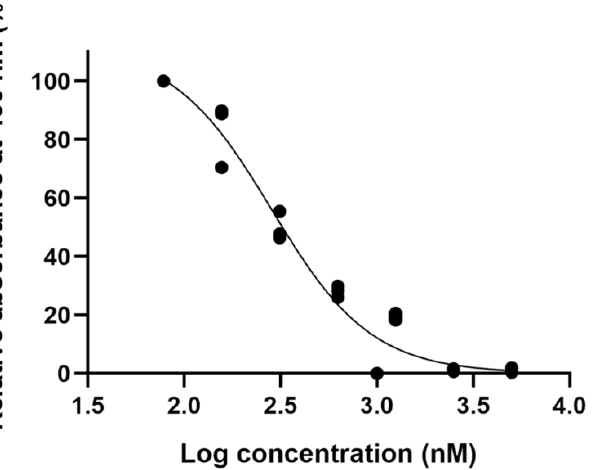
Figure 3. Analysis of cell viability in human umbilical vein endothelial cells (HUVECs). Cell viability was analyzed using Cell Counting Kit-8. The HUVECs were treated with 78.125–10,000 nM ellipticine for 24 h. The noncytotoxic concentration of ellipticine (<156.25 nM) was obtained. Dose– response curves for ellipticine at fixed substrate concentrations. Dotted lines represent the best fit of experimental data to the four-parameter Hill equation.